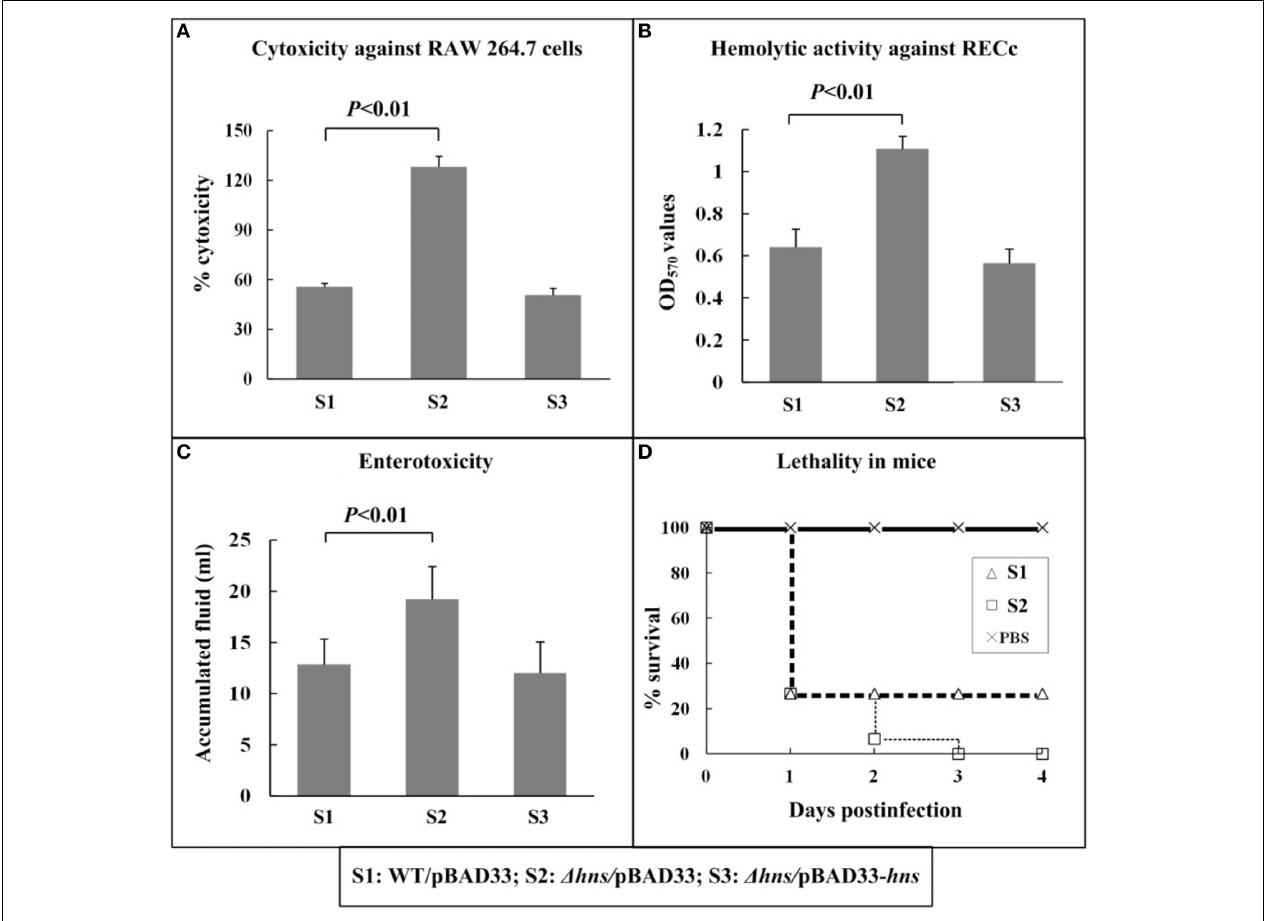
FIGURE 1 | Involvement of H-NS in virulence. The cytotoxicity against cultured RAW 264.7 cells (A) was evaluated in terms of the release of LDH. The hemolytic activity against RECs (B) was evaluated by detecting the